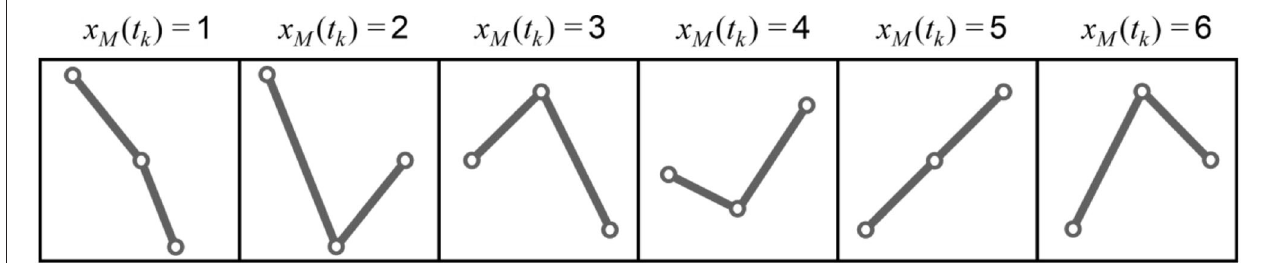
FIGURE 2 | The six possible motifs for n = 3.